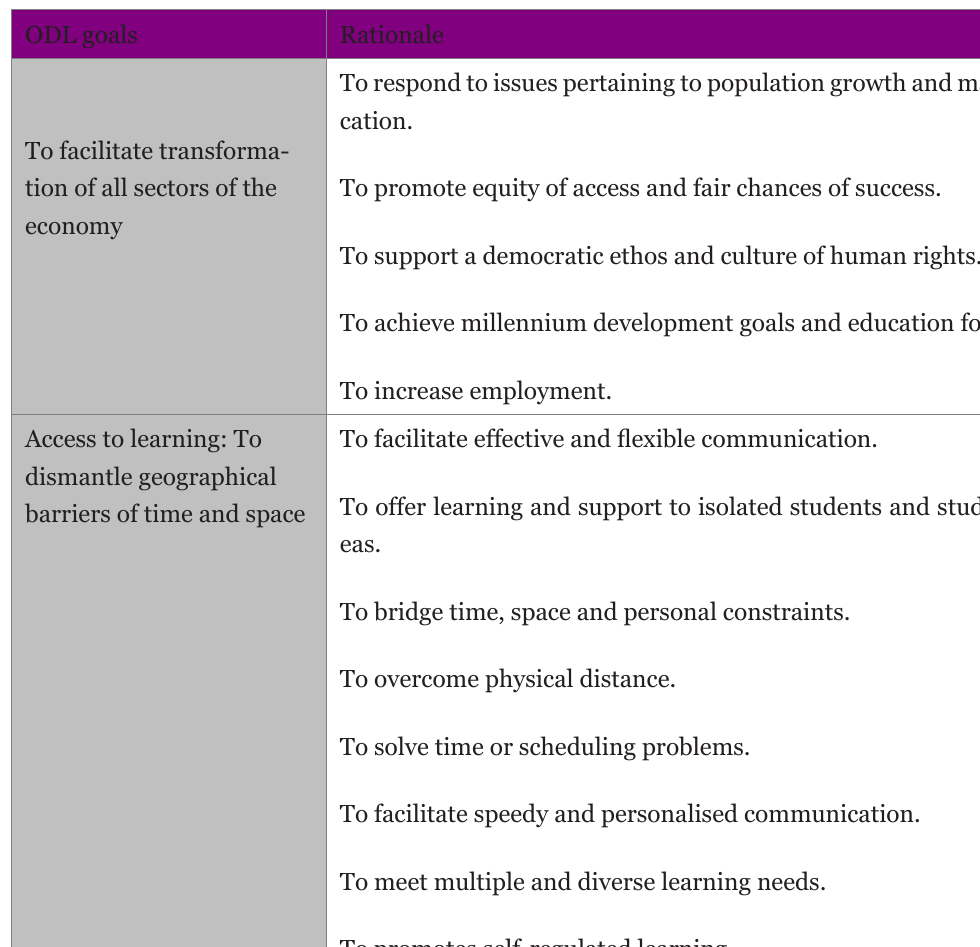
Table 3 Goals and Rationale for ODL ODL